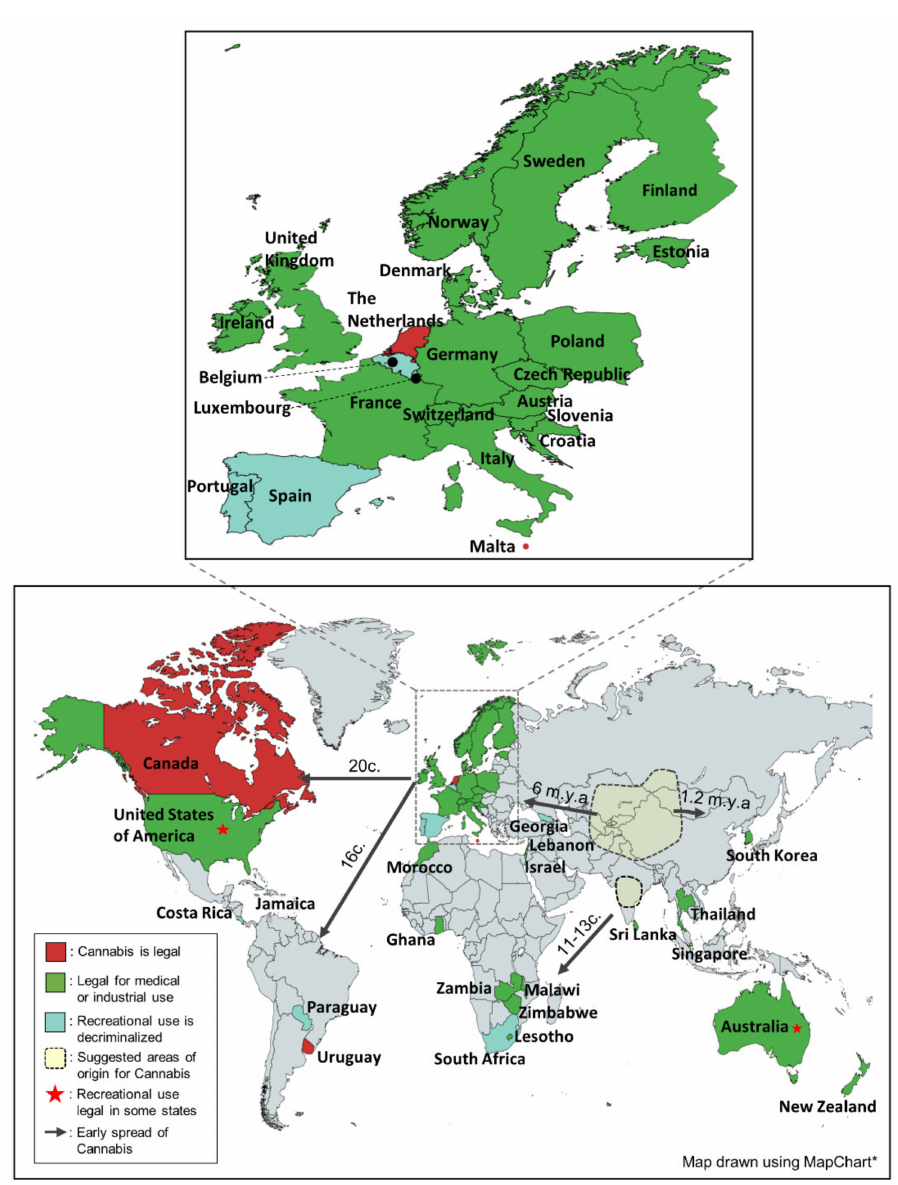
Figure 2. Legal status and early spread of Cannabis. From its proposed centers of origin (Central and Southern Asia), Cannabis spread to the other continents of the world. Today, Cannabis use for medical purposes is permitted in many countries, particularly in Europe and North America. Recreational Cannabis is permitted in Canada, The Netherlands, Malta and Uruguay while it is decriminalized in Portugal, Spain, Luxembourg, Belgium, Georgia, Costa Rica, Paraguay, Jamaica and South Africa. The recreational use of Cannabis is also permitted in some states of the US and Australia. A close-up part of Europe is shown in an insert map, 5.5 × magnified. ( c.: century, m.y.a.: million years ago , * https://mapchart.net/world.html (accessed on 10 March